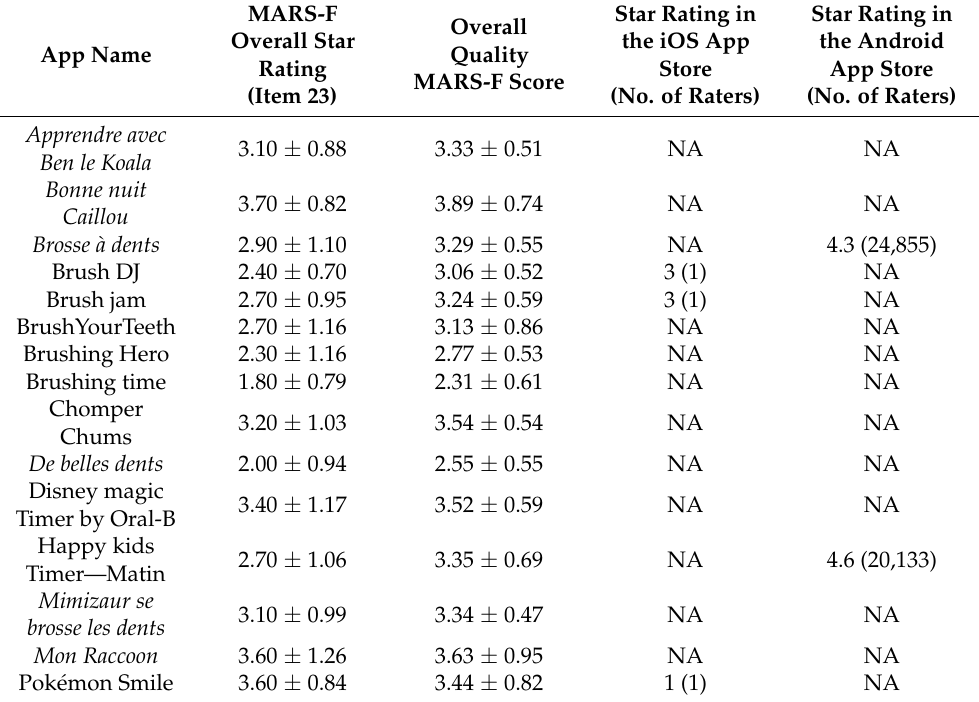
Table 3. MARS overall star rating, overall quality MARS score, star rating in the iOS App Store, and star rating in the Android app store of the fifteen oral hygiene-related mobile apps for children. NA: Not